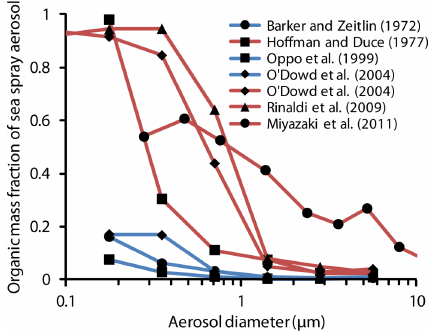
Figure 2. Size-resolved organic mass fraction of sea spray aerosol measured in clean marine conditions. The blue lines represent low biological activity periods and red lines represent high biological activity periods.